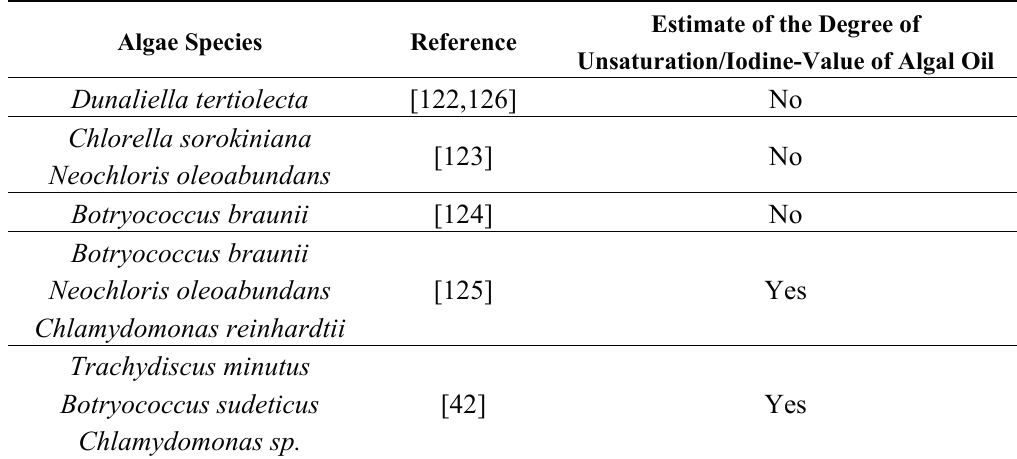
Table 3. The list of articles focused on the analysis of algae employing Raman